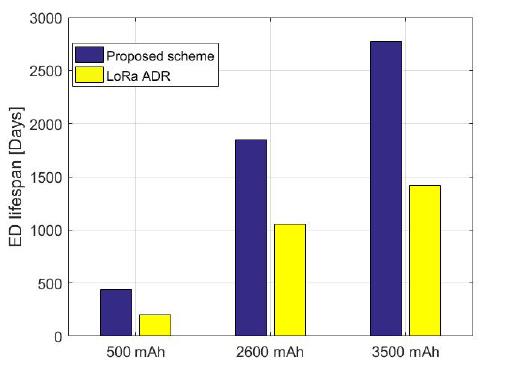
Figure 17. Comparison of the proposed scheme against LoRa’s default ADR in terms of ED lifetime for different battery